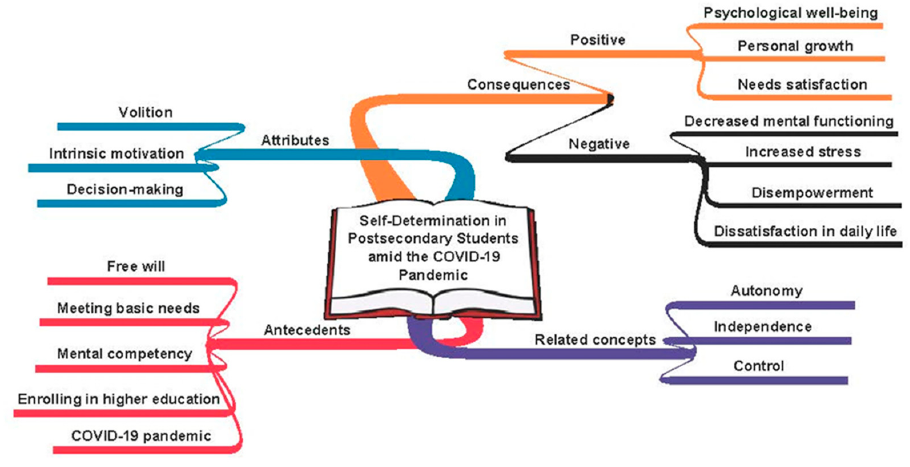
Figure 1. Conceptual Map of Self-Determination.